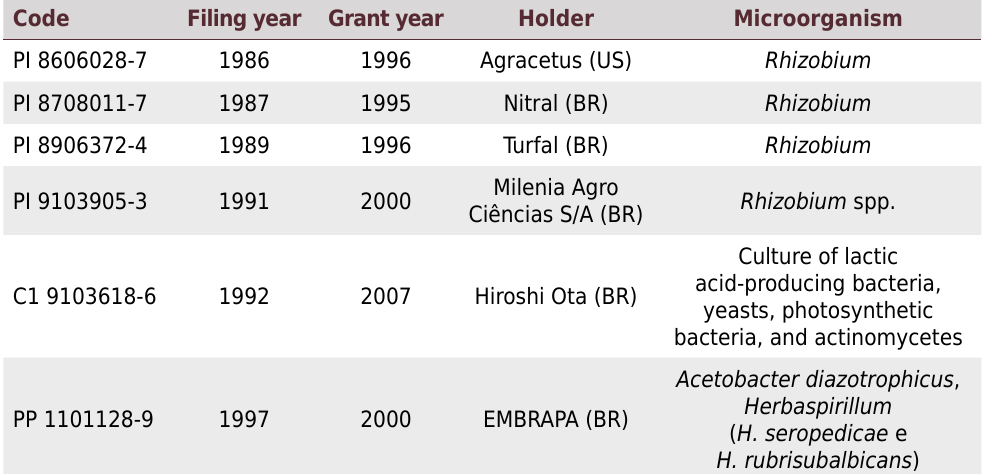
Table 1. Characterization of patents granted in the period 1981–2000